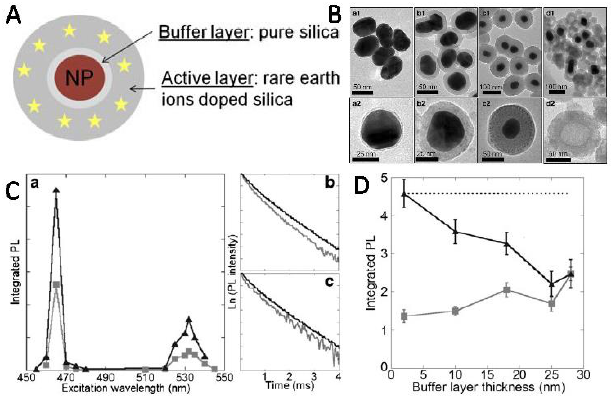
Figure 5. ( A ) Schematic illustrations of multilayer nanostructures. ( B ) Transmission Electron Mi- croscope (TEM) of Au@SiO 2 nanostructures with different silica shells. ( C ) The excitation spectra when the emission wavelength is 615 nm ( a ), and the decay curves under 465 nm ( b ) and 532 nm ( c ) excitation. ( D ) Integrated PL intensities excited at 532 nm of sample-loaded (gray closed squares) and dissolved (black closed triangle) Au NPs. Reference [117].